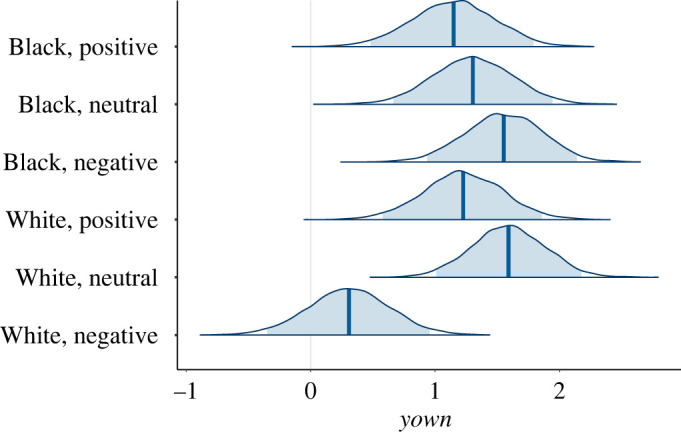
Posterior probability distributions for µown. The shaded areas show the 95% credible intervals.